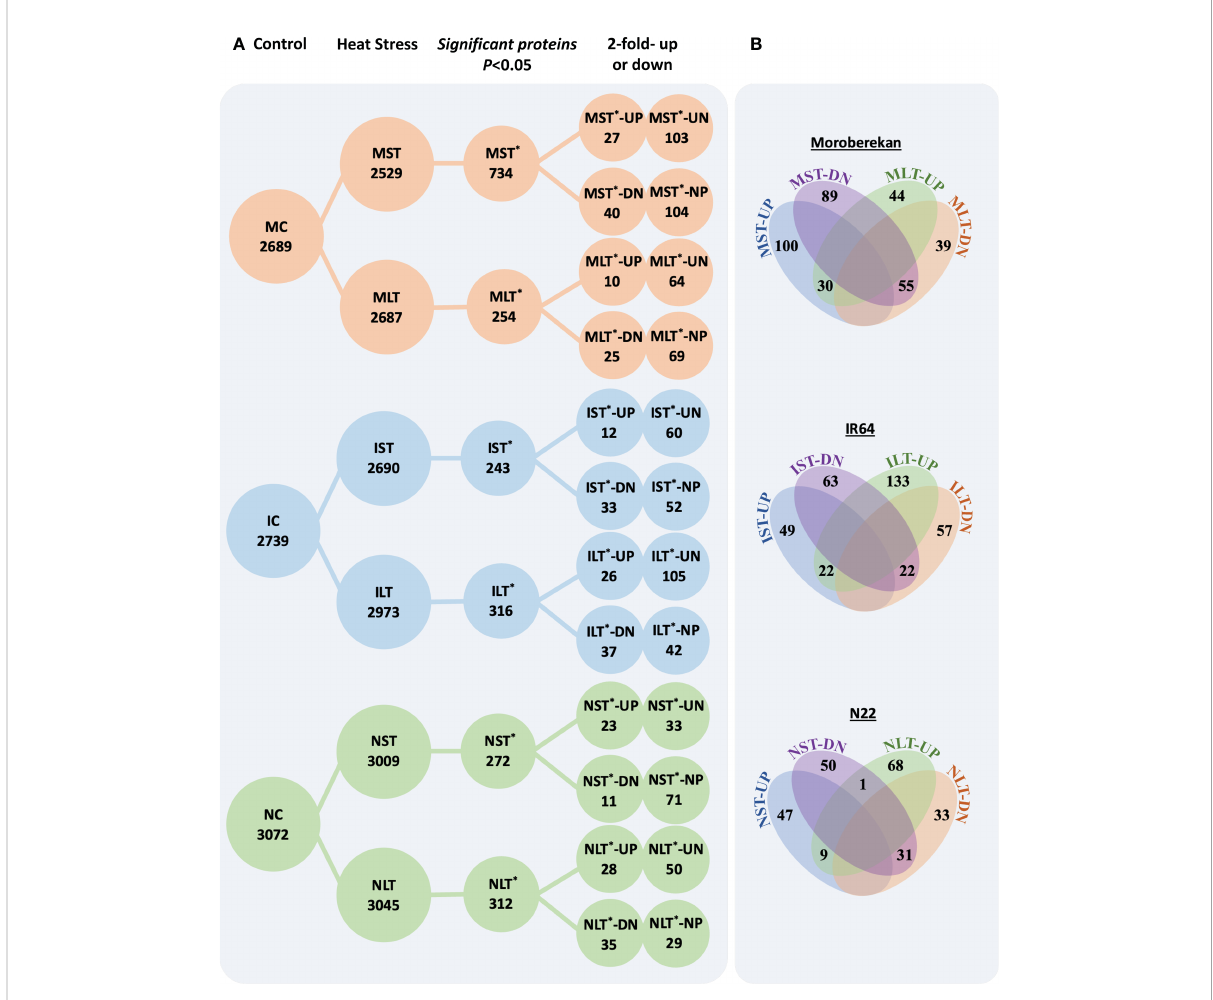
FIGURE 2 (A) The differentially expressed proteins in different rice genotypes under different heat stress regimes. (B) Venn diagrams show the overlapping signi fi cant and differentially expressed proteins between different datasets in each genotype. ST, Short term heat stress; LT, Long-term heat stress; MC, Moroberekan control; MST, Moroberekan ST_HS; MLT, Moroberekan LT_HS; IC, IR64 control; IST, IR64 ST_HS; ILT, IR64 LT_HS, NC, N22 control; NST, N22 ST_HS; NLT, N22 LT_HS; UP, upregulated; DN, downregulated, *-differentially expressed proteins numbers; UN-uniquely present in HS, proteins present in the heat stress sample but not in control; NP-not present in HS, proteins present in control but not detected in the heat stress